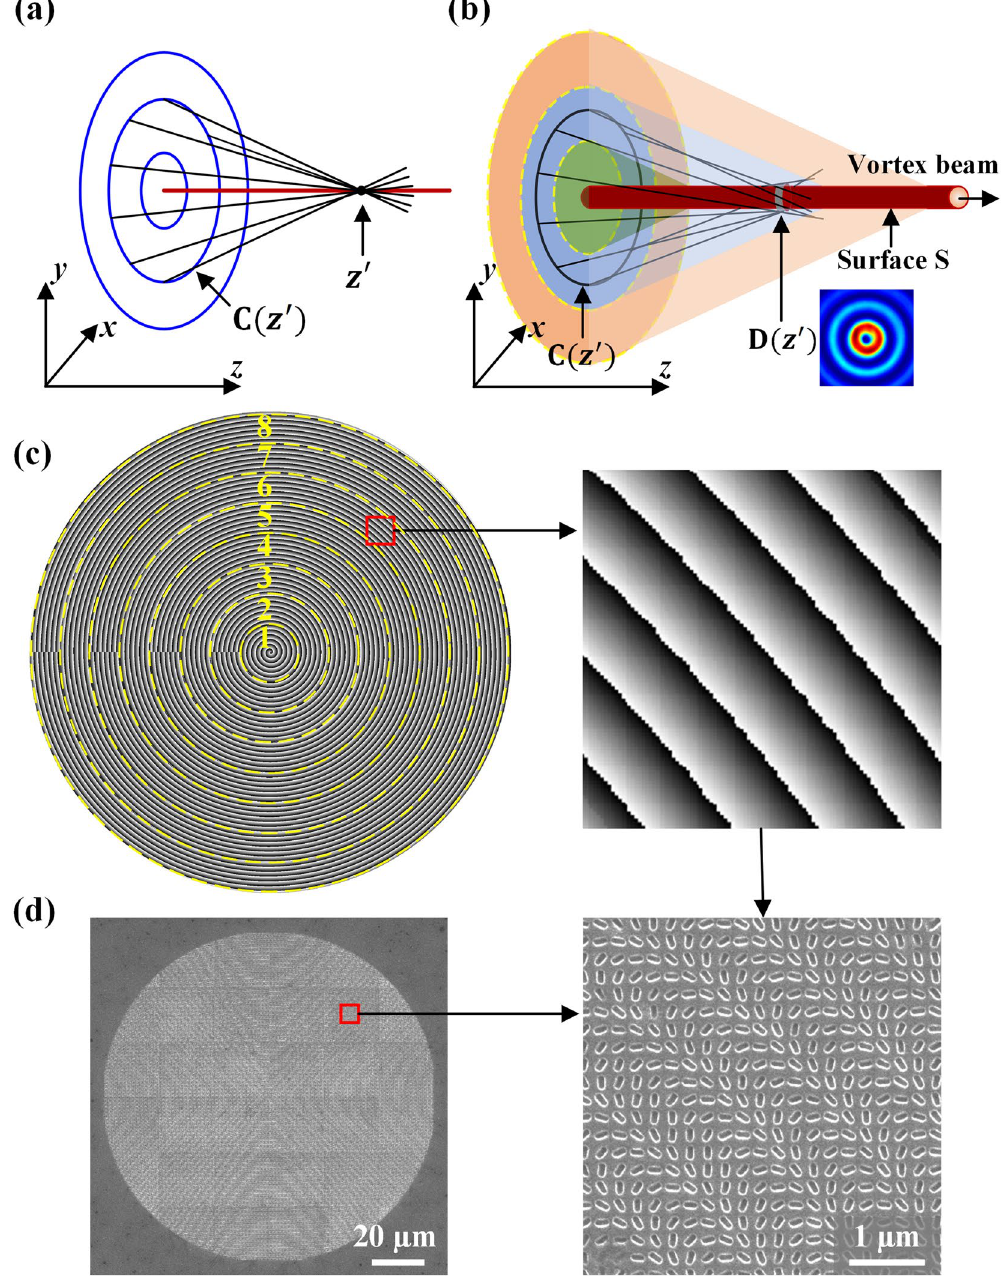
Figure 2. ( a ) The formation of caustic curve. ( b ) The caustic theory with the applied vortex structure into the initial optical field. The input plane is separated by yellow circles to several circular zones of different TCs. ( c ) The left figure is the phase distribution encoded on the metasurface with eight zones with different TC( n ) = 0.5 n − 1.5, and n = 1, 2, ∙∙∙, 8. The right figure is the magnified plot of the red rectangular region. ( d ) The left figure is the complete SEM picture of the entire fabricated metasurface, and the right figure is the magnified SEM picture of the red rectangular